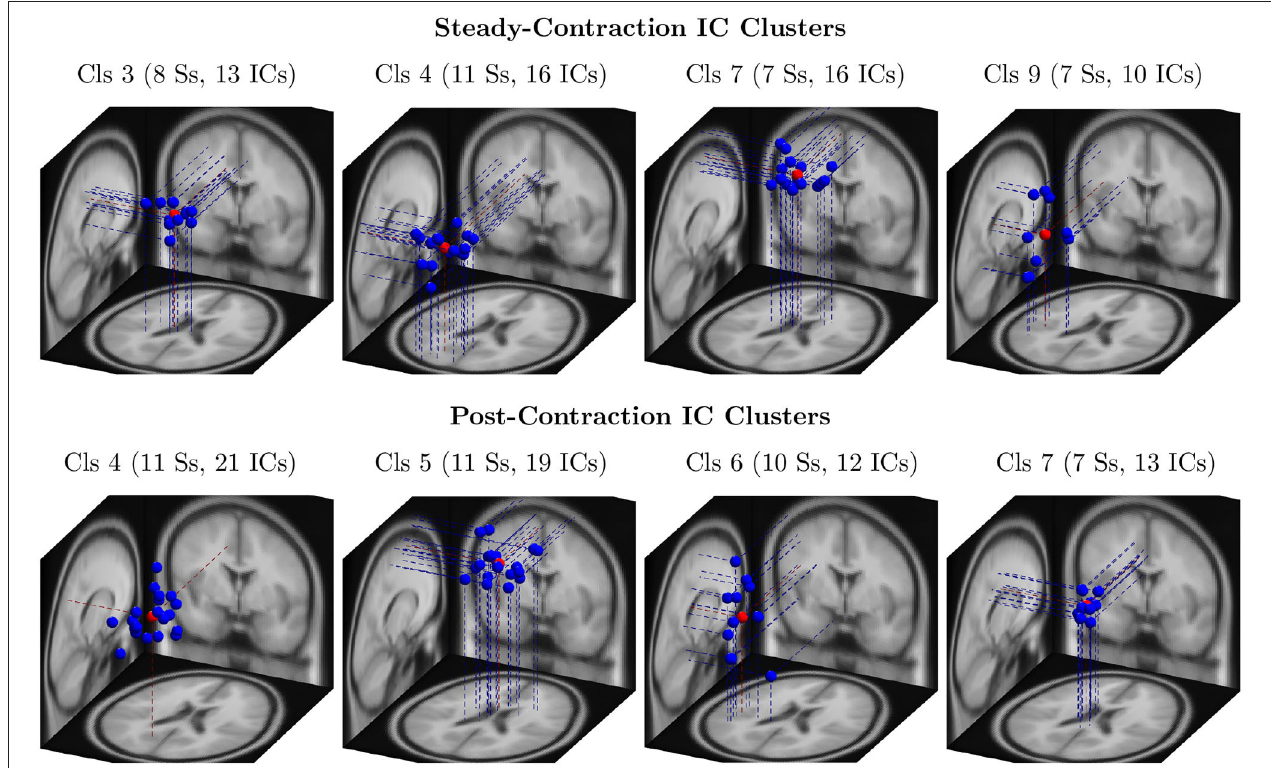
FIGURE 3 | The clusters of equivalent dipoles were identified based on their location and orientation with the k -means algorithm as described in Section4 for source-level analysis. Each IC cluster (Cls) is assigned an arbitrary index for identification; the number of ICs constituting the cluster and the number of associated subjects (Ss) are provided within the parentheses. The IC clusters represent plausible neural sources estimated from steady-contraction EEG (row 1) and post-contraction EEG (row 2), and they are located in the following brain regions: (row 1) Cls 3 - left cingulate gyrus; Cls 4 - left superior parietal gyrus; Cls 7 - right paracentral lobule; Cls 9 - left transverse temporal gyrus; (row 2) Cls 4 - left precuneus; Cls 5 - right paracentral lobule; Cls 6 - left transverse temporal gyrus; and Cls 7 - left cingulate gyrus. The dipoles are marked with blue dots and the cluster centroids estimated by the k -means with red